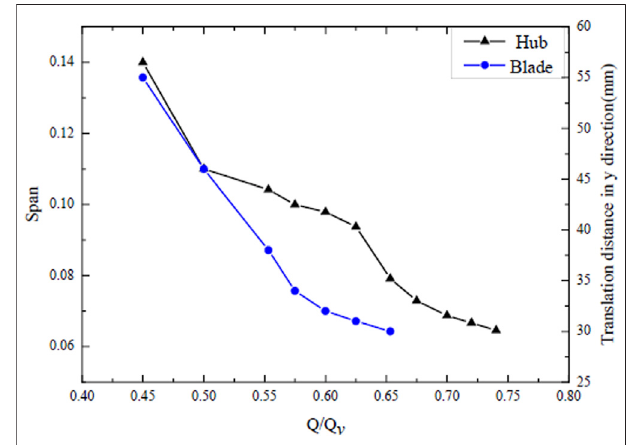
FIGURE 12 | Eddy dissipation at different fl